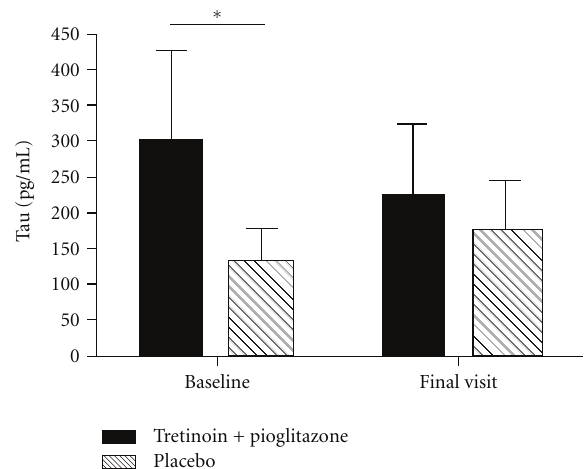
Figure 2: Average pNFH levels in patients who lost < 0.5 ALSFRS- R points per month compared to patients who lost > 0.5 ALFRS-R points per month. ( ∗ Significant di ff erence between the slow and fast progressors, P = 0 . 03 by Mann-Whitney t -test). Error bars denote standard